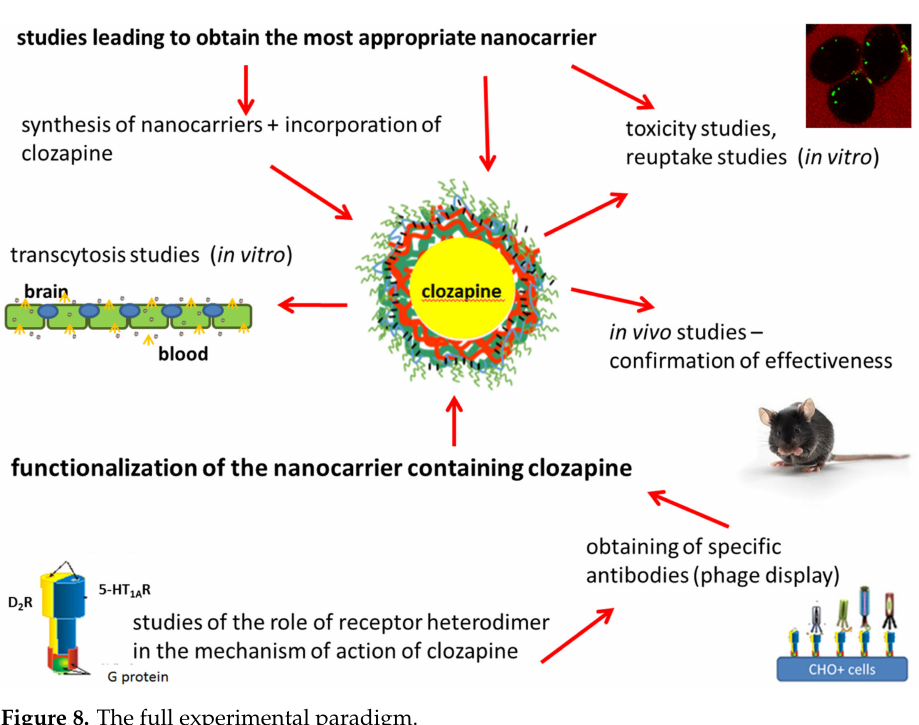
Figure 8. The full experimental